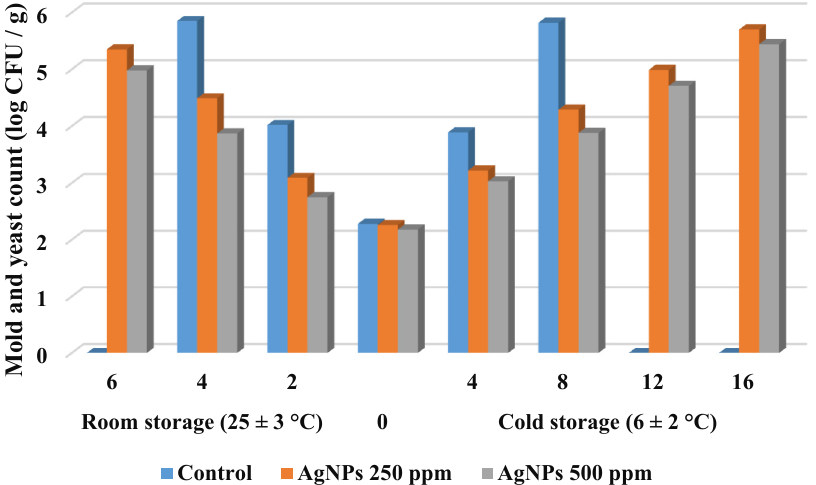
Figure 7. Changes in yeast and mold counts (log CFU/g) of strawberry fruit during storage.